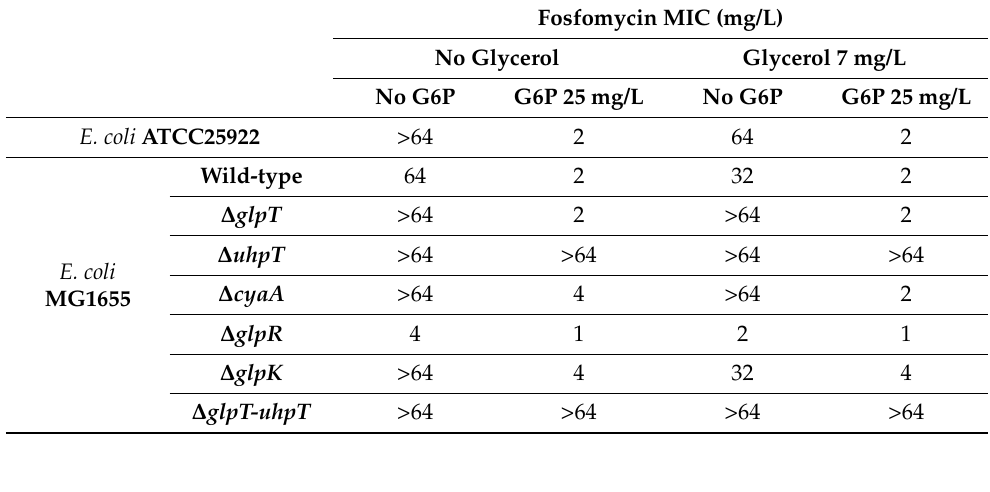
Table 1. Fosfomycin MIC (mg/L) results by agar dilution without and with 7 mg/mL of glycerol and 25 mg/L of glucose-6-phosphate (G6P).